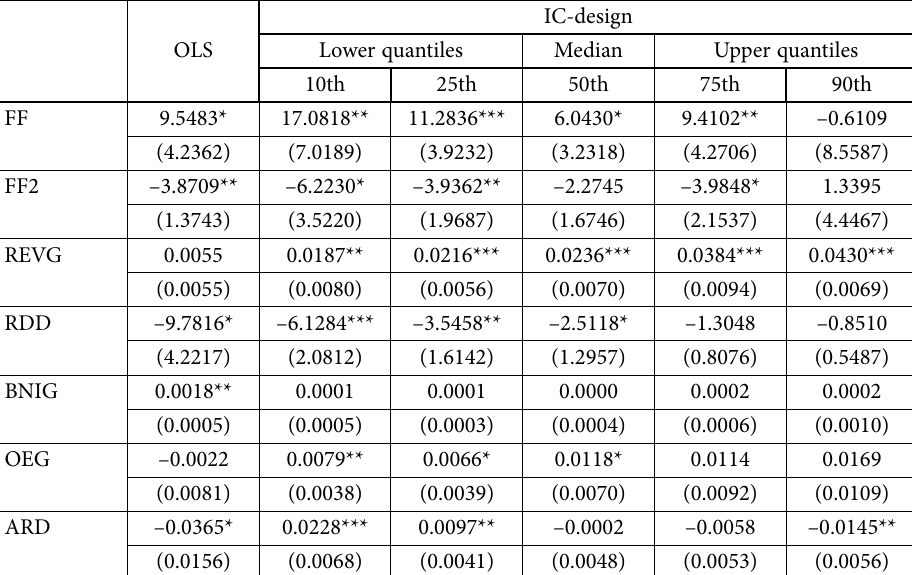
Table 13. OLS and QR results for IC-design and IC-manufacturing using